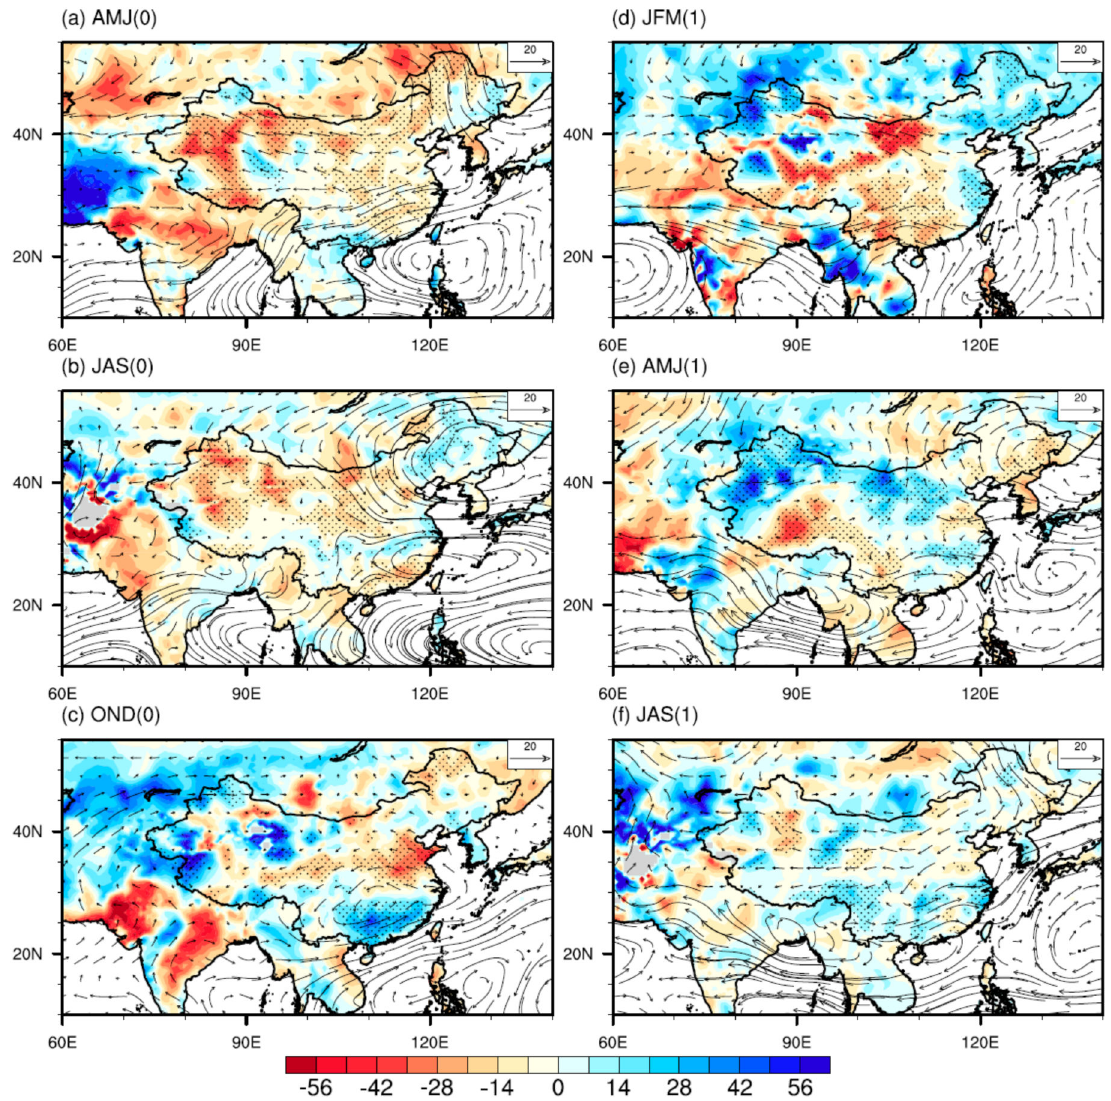
Figure 3. Composites of precipitation (%) and vertically integrated water vapor flux (kg · m − 1 · s − 1 ) anomalies during ( a ) April to June (AMJ(0)), ( b ) July to September (JAS(0)), and ( c ) October to December (OND(0)) in the developing phase, and the following ( d ) January to March (JFM(1)), ( e ) April to June (AMJ(1)), and ( f ) July to September (JAS(1)) for the pure El Nino years. Precipitation anomalies are presented as percent di ff erences from the long-term average during 1950–2013. The stippling represents statistically significant at the 90% level for